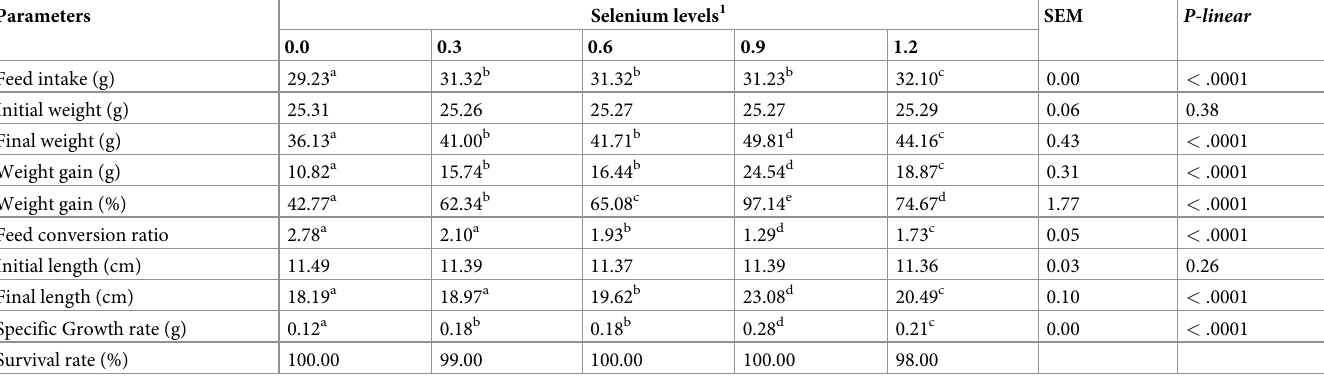
Table 3. Growth performance of juvenile silver carp fed on different levels of selenium methionine.